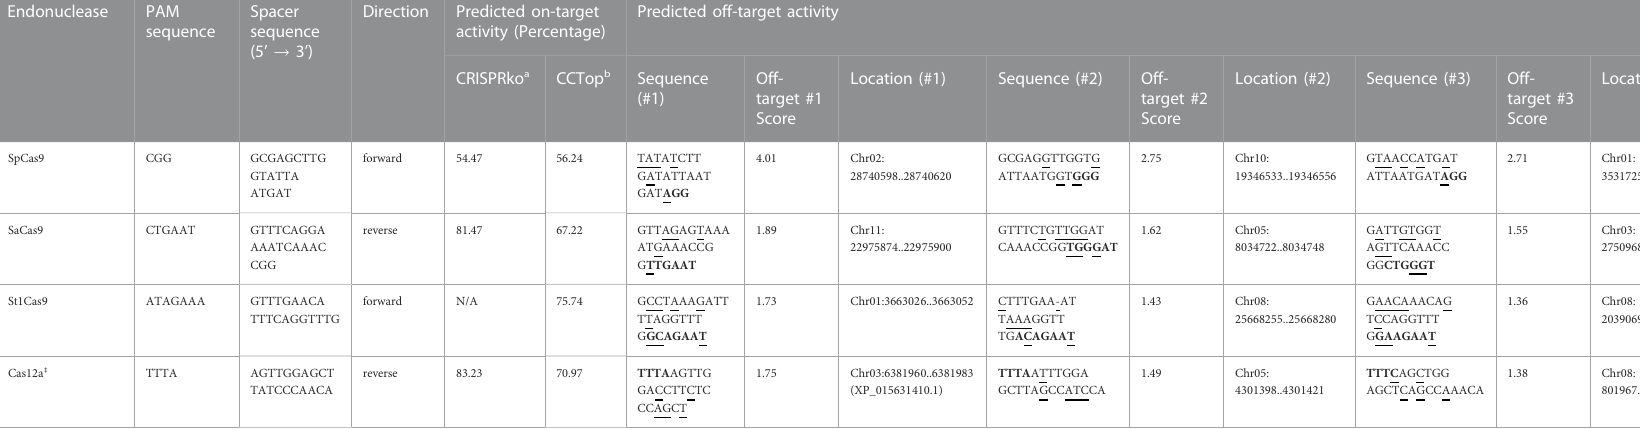
TABLE 2 Summary of the different target-speci fi c